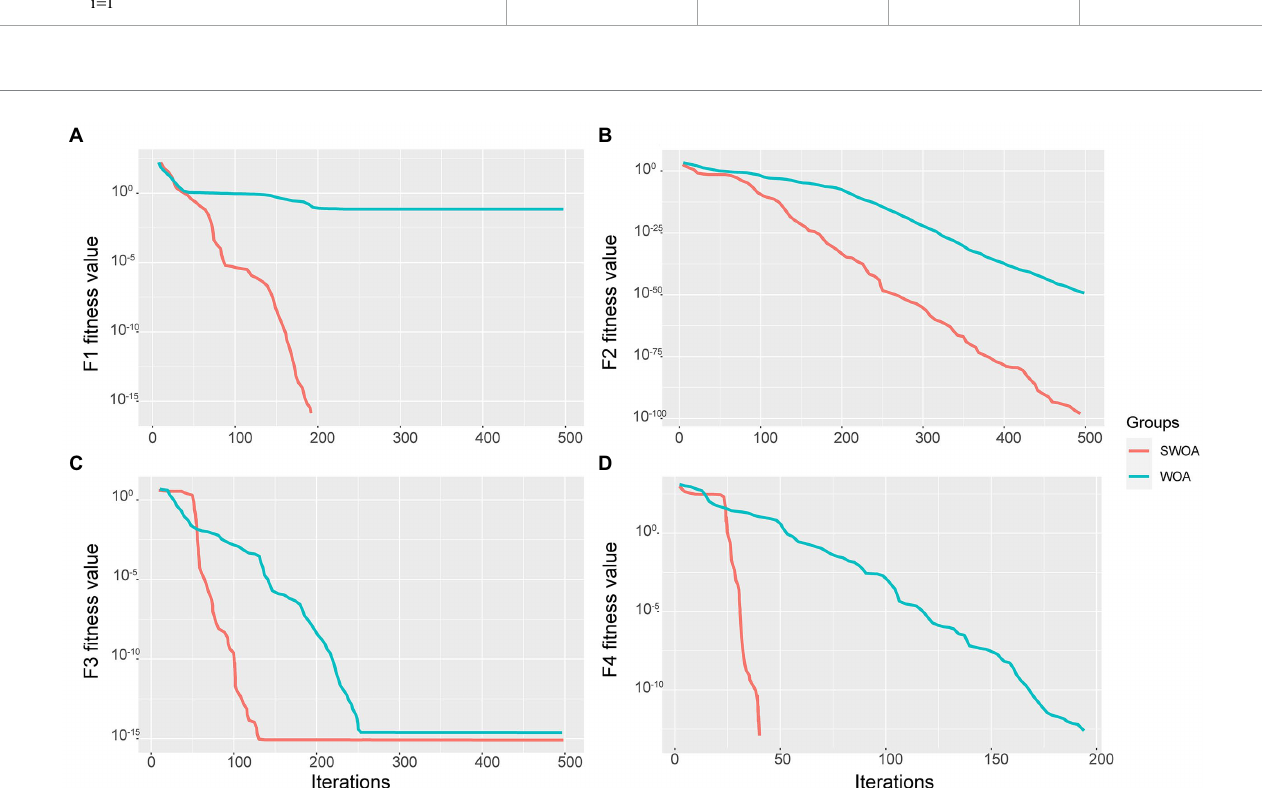
FIGURE 8 RF and RF-SWOA model performance evaluation. (A) Griewank simulation function; (B) Schwefel 2.20 simulation function; (C) Ackley simulation function; (D) Rastrigin simulation